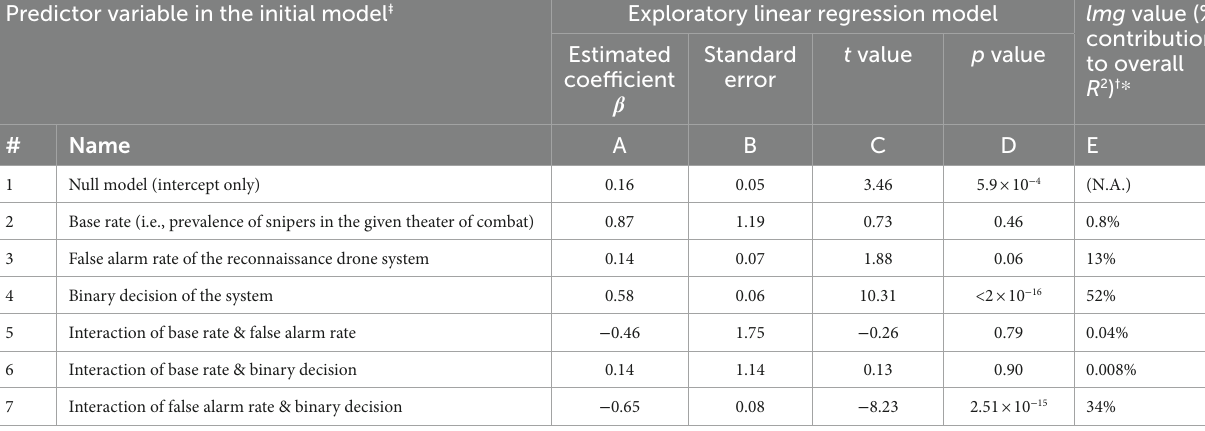
TABLE 3 Summary of regression modeling of the reported probabilities in Experiment 3. Predictor variable in the initial model ‡